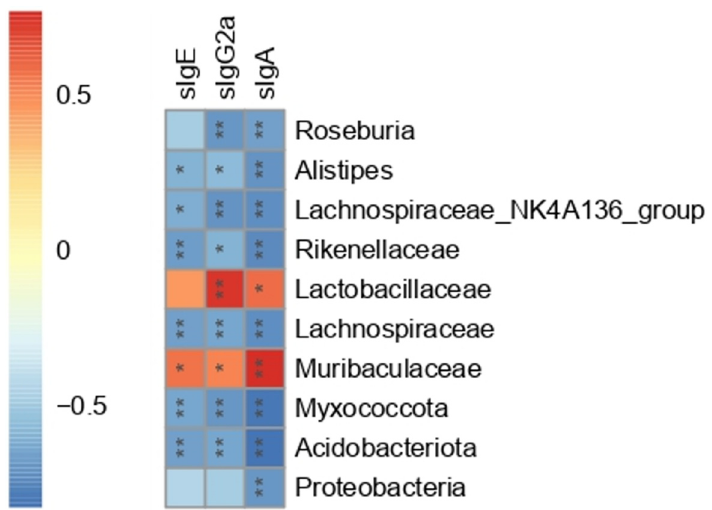
Figure 7. Heat map of Spearman correlation between serum peanut-specific antibodies (sIgE, sIgG2a, and sIgA) and 10 bacterial OTUs at the phylum, family, and genus levels ( n = 6 for PE group; n = 5 for Ad and Ctrl groups). Red represented a positive correlation, and blue represented a negative correlation. ns: no significance; *: p < 0.05; **: p < 0.01.